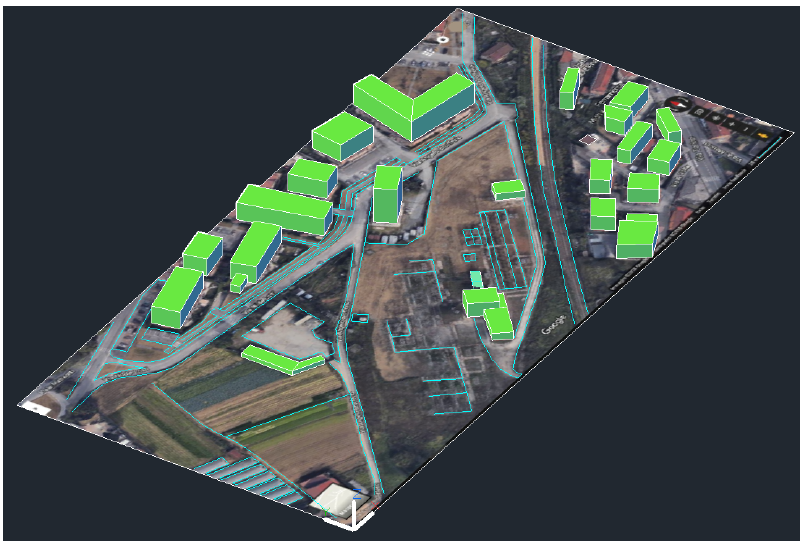
Figure 7. Three-dimensional representation of the model. Imagery c (cid:13) 2019 Maxar Technologies, Map data c (cid:13) 2019